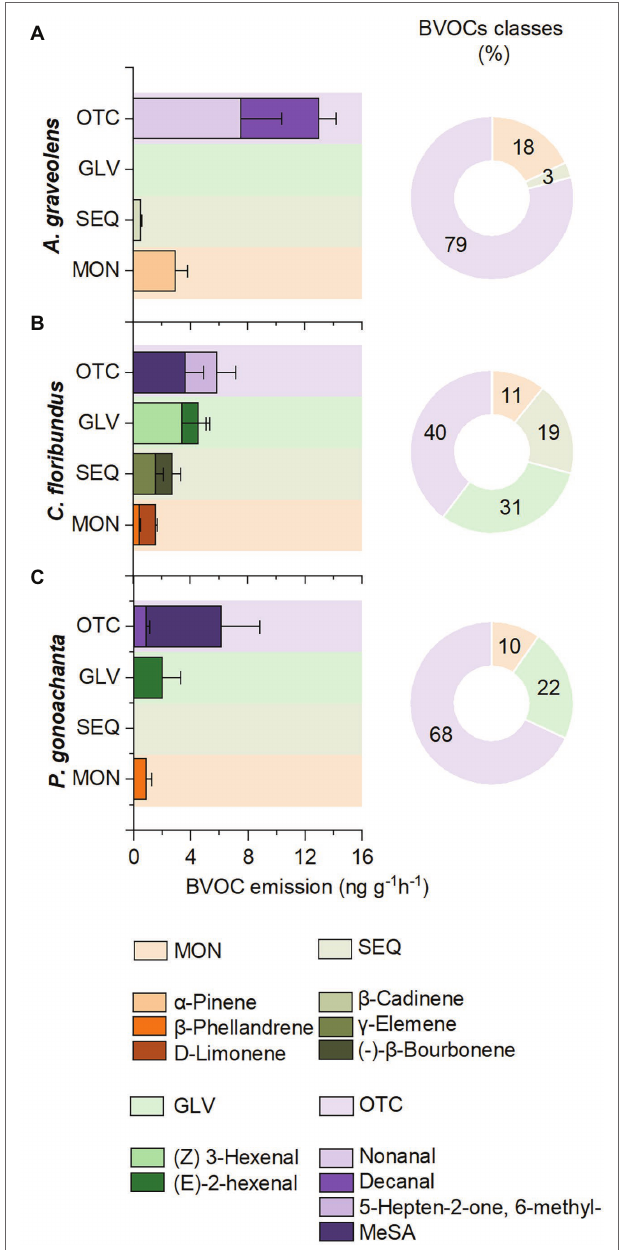
FIGURE 2 | Constitutive emission rates and percentage of different classes of biogenic volatile organic compounds (BVOCs): monoterpenes (MON), sesquiterpenes (SEQ), green leaf volatiles (GLV), and other compounds (OTC) in seedling of (A) Astronium graveolens , (B) Croton floribundus , and (C) Piptadenica gonoacantha exposed to control conditions (CT). Data are mean ± standard